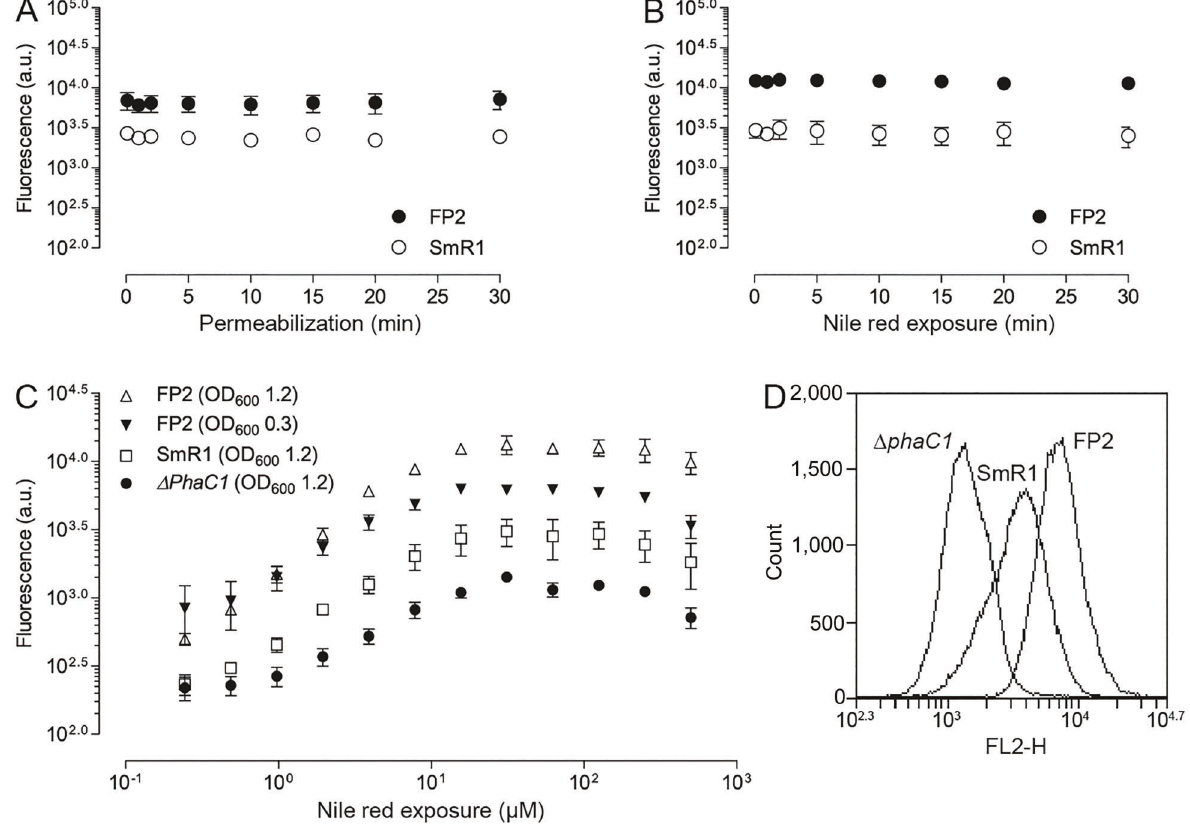
Figure 3. Incubation time required for cell permeabilization and Nile red (NR) staining. Bacteria were grown at an OD 600 of 1.2, 0.1 mL was centrifuged (1 min at 13,400 g ), and resuspended in 1 mL of TBAC buffer containing 50% of EtOH. A , Exposure with EtOH during 0 to 30 min and cells stained with NR (9.42 m M). B , After 1 min of exposure in TBAC buffer containing 50% of EtOH, the bacterial suspensions were incubated with NR (9.42 m M) during 0 to 30 min. C , After 1 min of exposure of cells in TBAC buffer containing 50% of EtOH, the bacterial suspensions were stained with NR (0 to 500 m M) during 1 min, centrifuged (1 min at 13,400 g ), and resuspended in TBAC buffer for analysis by fl ow cytometry. Fluorescence data (arbitrary units, a.u.) are reported as means ± SD of 3 independent experiments with H. seropedicae strain SmR1 and A. brasilense strain FP2, by using the median fl uorescence intensity values in the FL2-H channel. D , Histogram overlay of three samples, a mutant strain of H. seropedicae , D phaC1 , H. seropedicae strain SmR1, and A. brasilense strain FP2, using the optimized concentration of NR (31.25 m